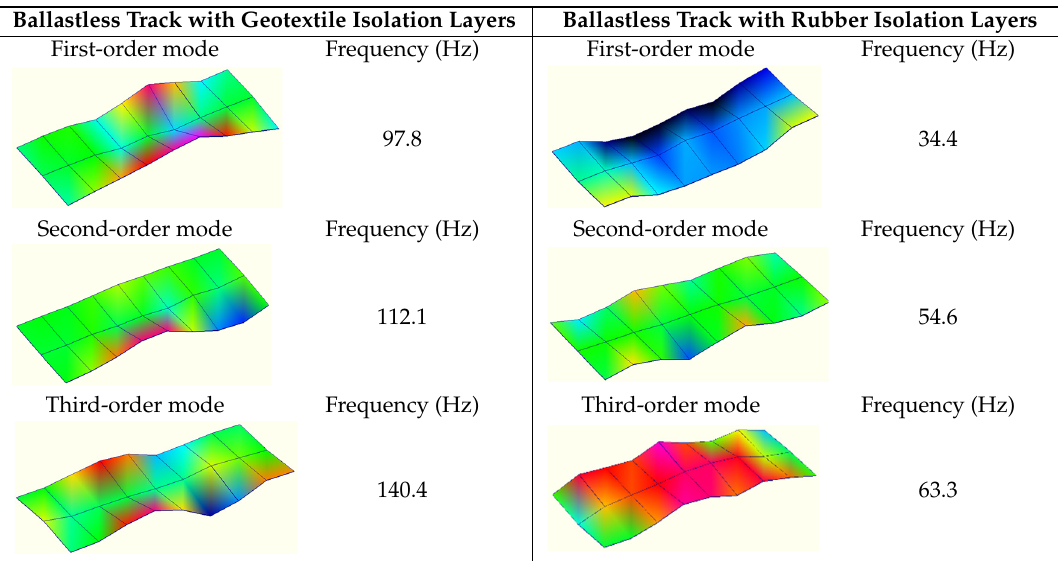
Table 1. Modal shapes of track slab in the two types of ballastless tracks.